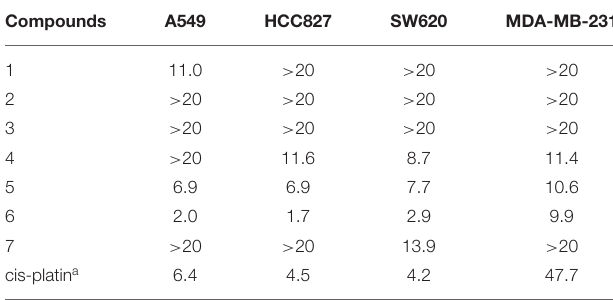
TABLE 4 | Cytotoxicity of compound 6 against two drug-resistant HCC827 cells (Gefitinib-resistant, Osimertinib-resistant) (IC 50 µ M). Compounds HCC827 (Gefitinib-resistant HCC827 strain) (Osimertinib-resistant strain)